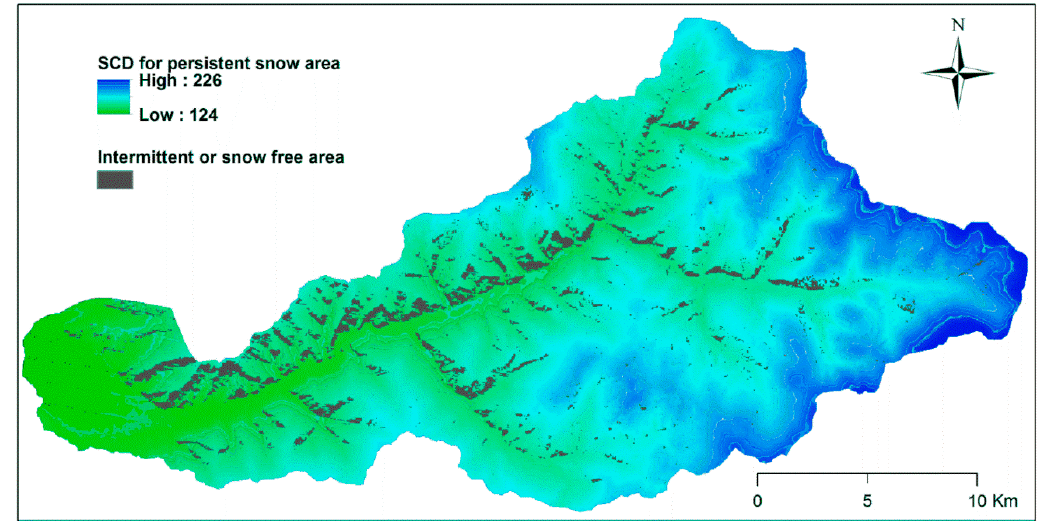
Figure 9. The total snow cover duration (SCD) days in Sugnugur catchment calculated only for persistent snow cover area. The intermittent and snow free areas were excluded due to their unknown snow accumulation periods.